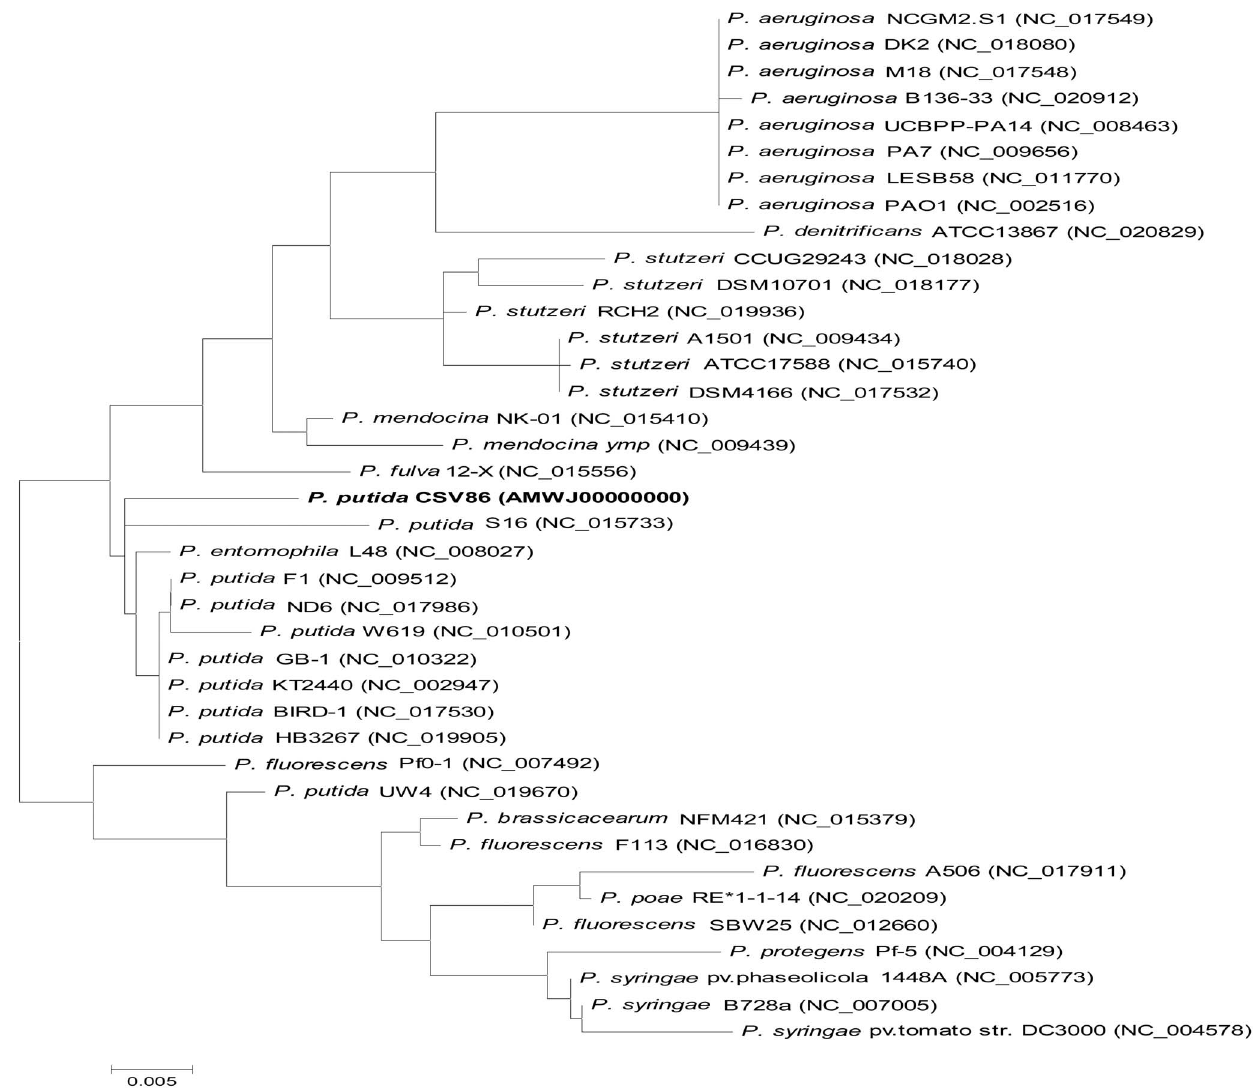
Figure 1. Phylogenetic neighbor-joining tree of Pseudomonasputida CSV86. The tree is constructed from 16S rRNA gene sequences from 38 completely sequenced Pseudomonas spp. The phylogenetic analysis was performed using MEGA 5.2 and the resultant Maximum Likelihood tree shows close taxonomic relationship of P. putida CSV86 to P. putida S16.